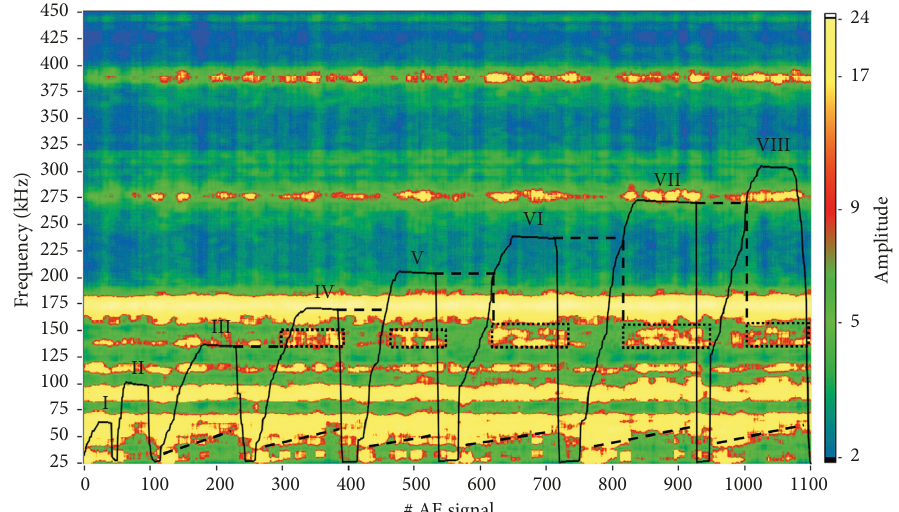
Figure 4: An example of a smoothed spectrogram for a sample of the first group of the “A” series with superposition of the σ ( N ) dependence (Roman numerals indicate the numbers of the loading cycles).